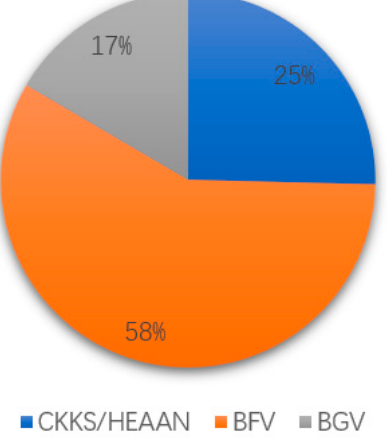
Figure 13. Proportion of homomorphic encryption schemes used in different documents.